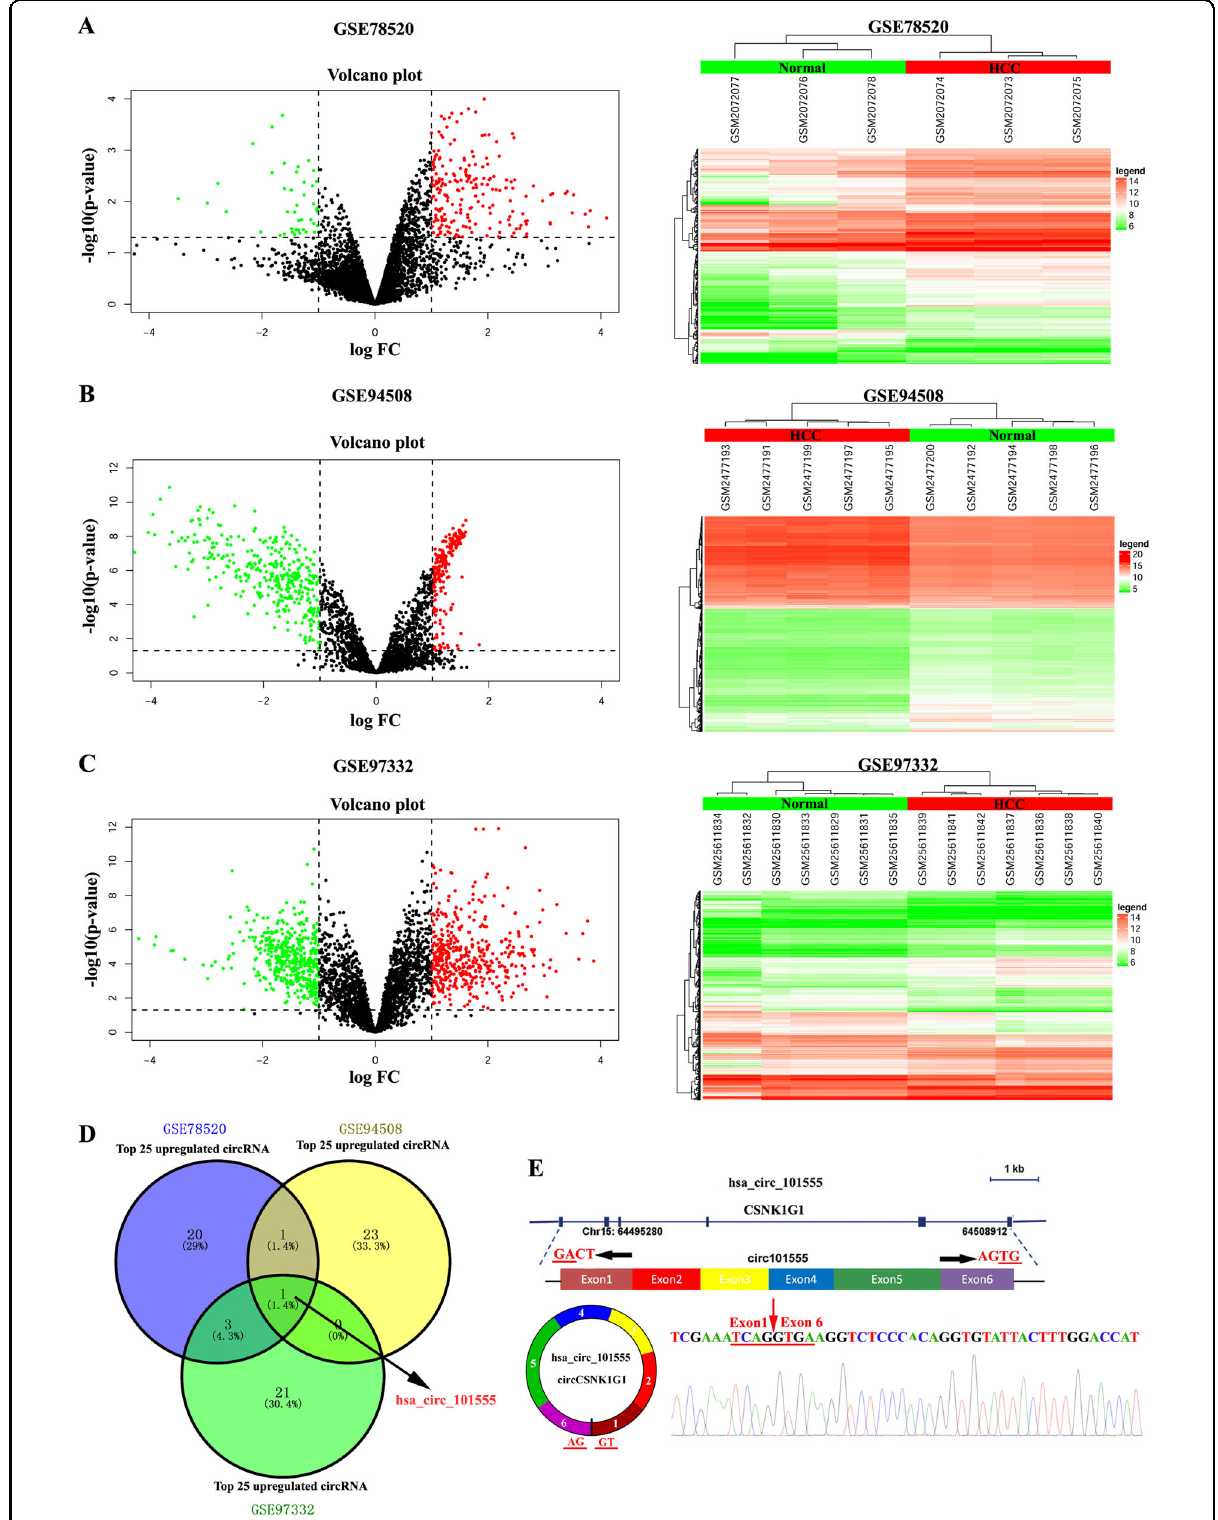
Fig. 1 circRNA expression pro fi les in HCC and paired nontumorous samples. A – C Volcano and scatter plots show variation in circRNA expression between HCC and nontumor liver tissues from the GSE7852 ( A ), GSE94508 ( B ), and GSE97322 ( C ) datasets. D Venn diagram. E hsa_circ_101555 consists of six exons (exon 1 – 6, 815 nt) and is derived from the host gene CSNK1G1 . The existence of the back-splice junction was con fi rmed by Sanger